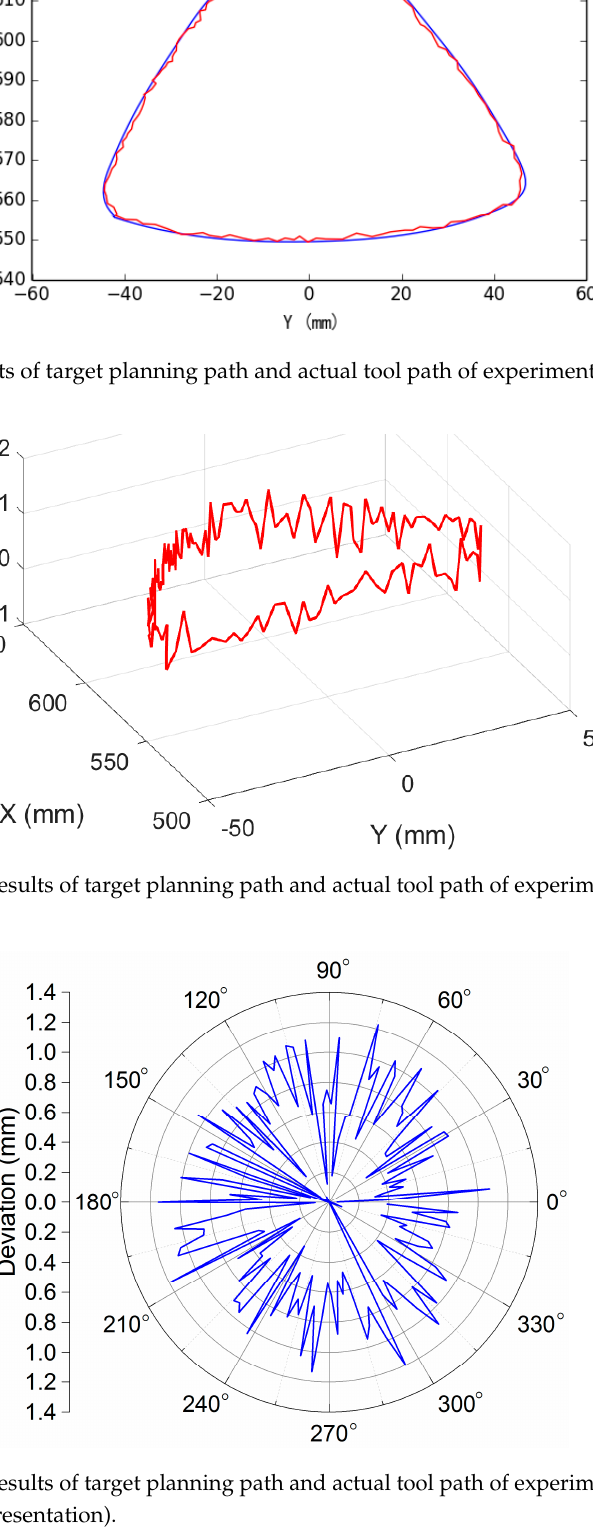
for disc of hub (polar representation). disc of hub (polar